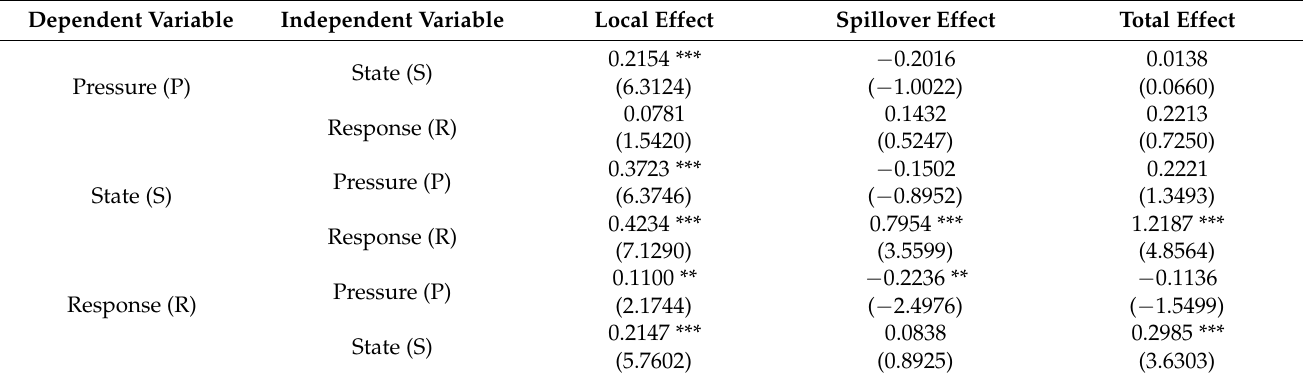
Table 3. Marginal effect reconstruction of Spatial Durbin